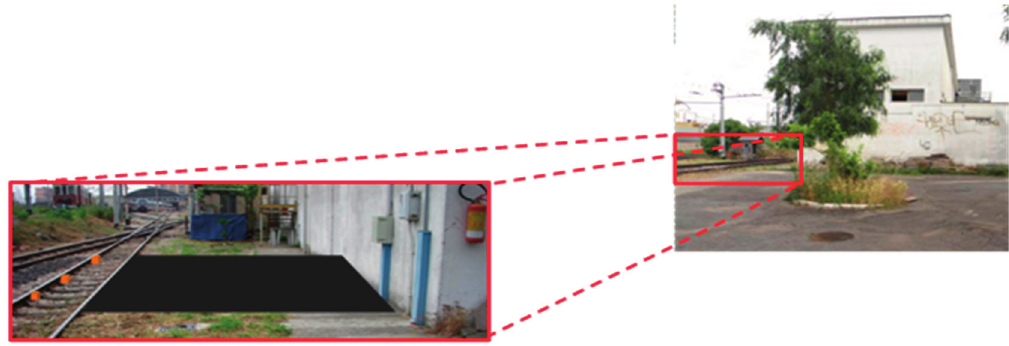
Figure 1. Ponticelli service area (Ente Autonomo Volturno-ex Circumvesuviana-Railway- Naples,